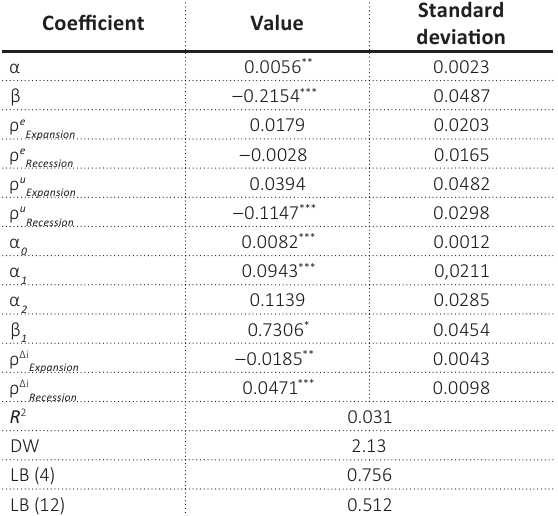
Table 7. Influence of the expected and the surprise components of the Federal Reserve